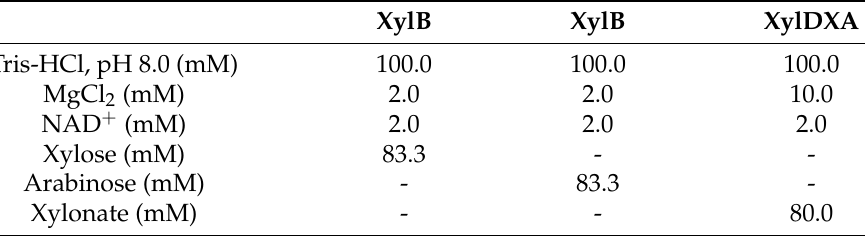
Table 1. Stock solution composition for the enzyme